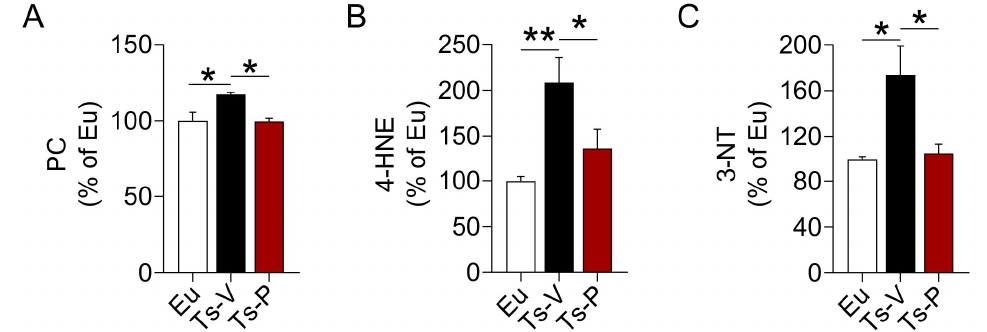
Figure 3. Reduced oxidative stress markers levels following KYCCSRK intranasal administration in Ts2Cje mice. ( A ) PC, ( B ) 4-HNE and ( C ) 3-NT levels were evaluated in the frontal cortex of Eu and Ts2Cje (Ts-V) mice treated with vehicle (saline) and Ts2Cje (Ts-P) mice treated with KYCCSRK peptide (0.5 mM) for two weeks (n = 4/group). Data were expressed as the percentage of Eu set as 100%. Data are shown as mean ± SEM. One-way ANOVA with Dunnett test: * p <0.05, ** p < 0.01.